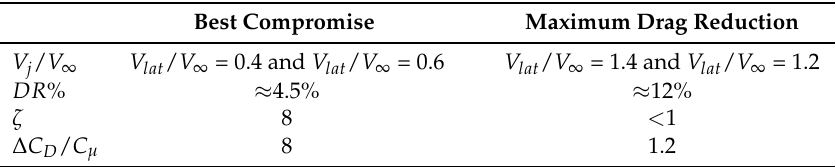
Table 3. Relevant forcing configurations identified for the current investigation.